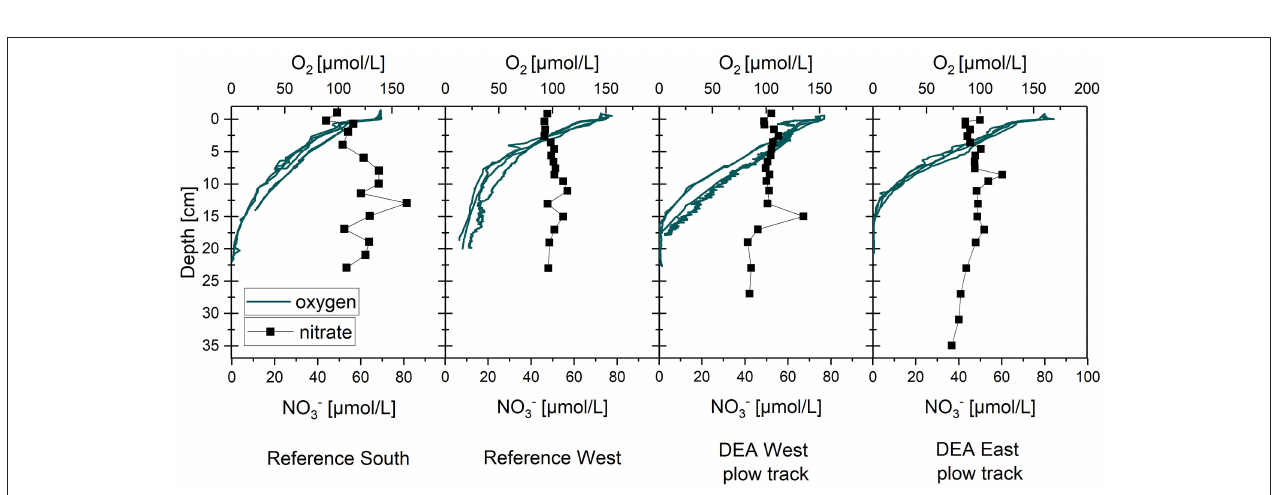
FIGURE 6 | Bottom water and pore water ex-situ oxygen and nitrate profiles of two undisturbed and two disturbed sites (MUCs). In each core, four to six oxygen profiles were